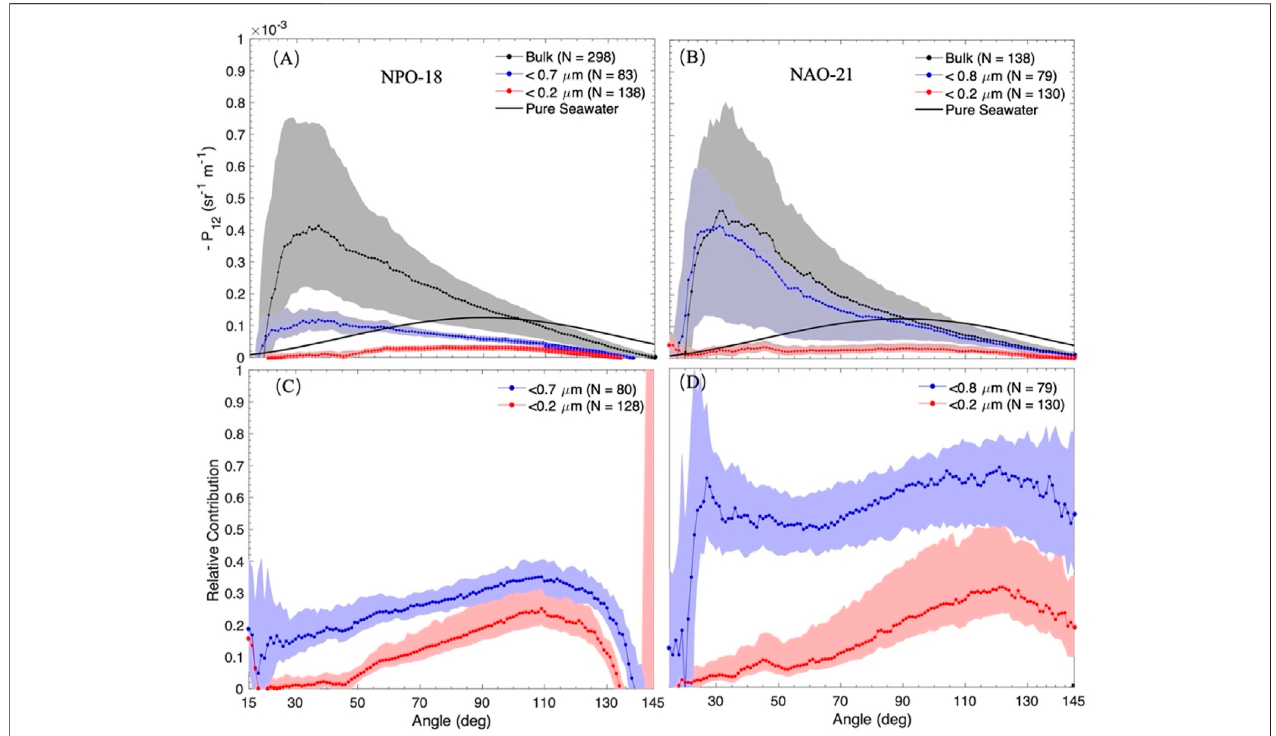
FIGURE4| Themedianvaluesofparticulate-P12measuredbytheLISST-VSFforun fi lteredsample(Bulk),0.7- μ m fi ltrate( < 0.7 μ m),and0.2- μ m fi ltrate( < 0.2 μ m)in the (A) NPO-18and (B) NAO-21sitesandtherelativecontributionbysubmicronparticlesinthe (C) NPO-18and (D) NAO-21sites.Theshadedarearepresentsthe25th and 75th percentile of the data. Theoretical pure seawater scattering (black solid line) was calculated using the Zhang et al. (2009) and Zhang et al. (2019) models.